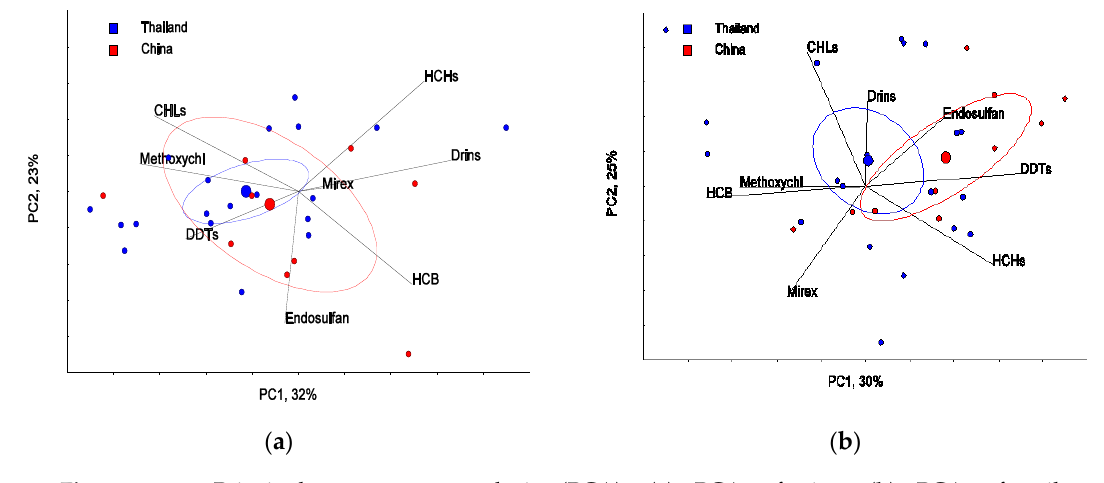
Figure 2. Principal component analysis (PCA): ( a ) PCA of rice, ( b ) PCA of soil from Thailand and China exposure to organochlorine pesticides (OCPs); chlordane (CHLs), methoxychlor (methoxychl), hexachlorobenzene (HCB), mirex, drins, hexachlorocyclohexanes (HCHs), dichlorodiphenyltrichloroethane (DDTs), endosulfans.